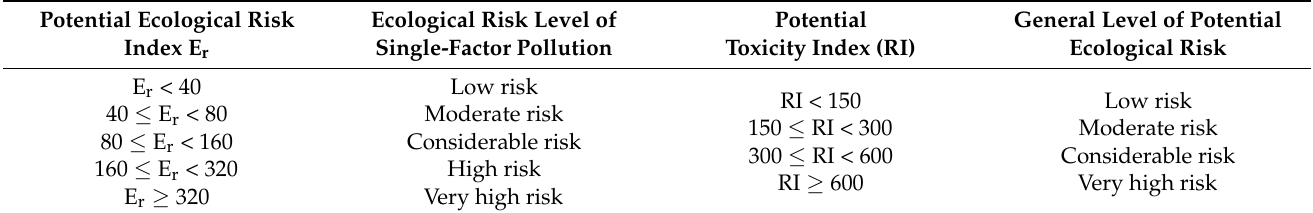
Table 2. Class standards for E r and RI.